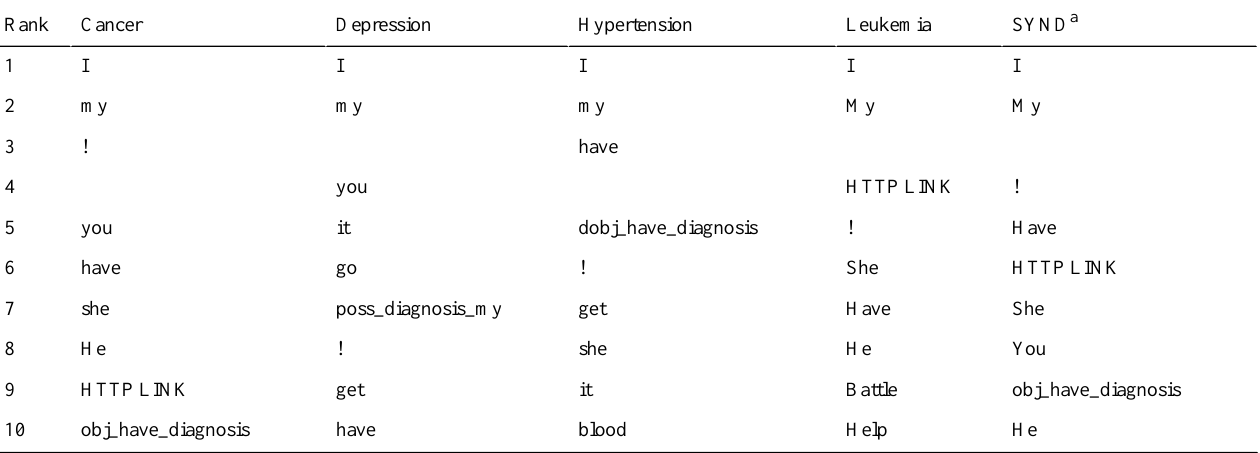
Table 3. The most informative features for homogeneous health mention